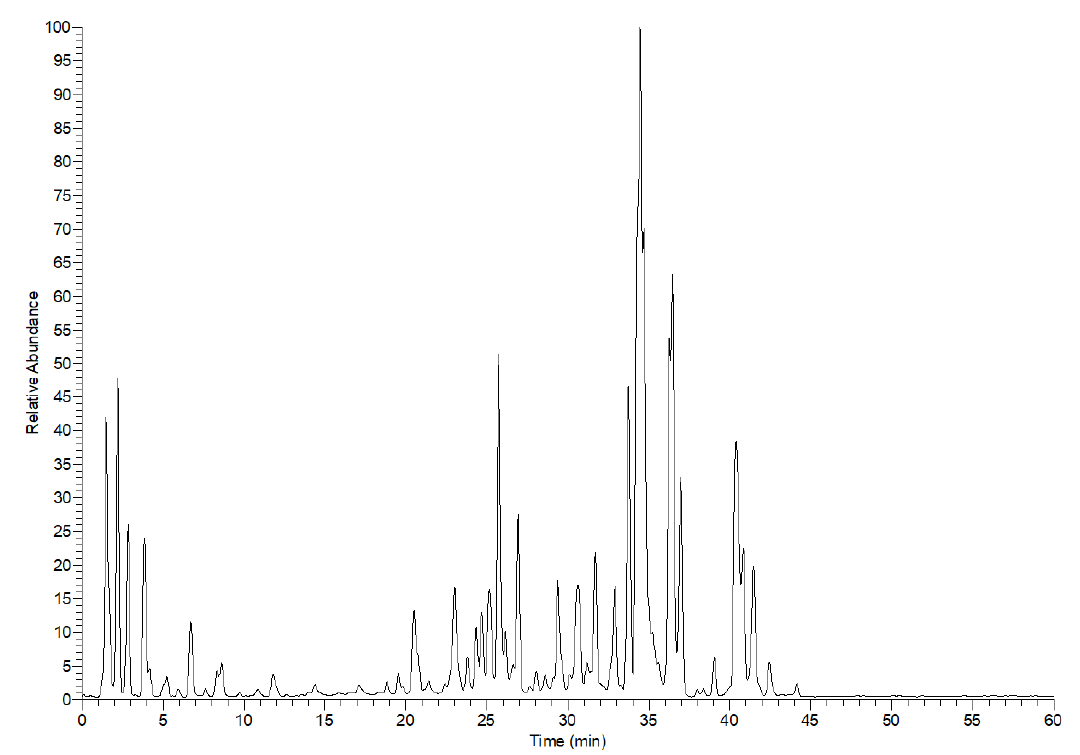
Figure 1. E. divinorum leaf extract profile in the negative ion mode by LC-MS.